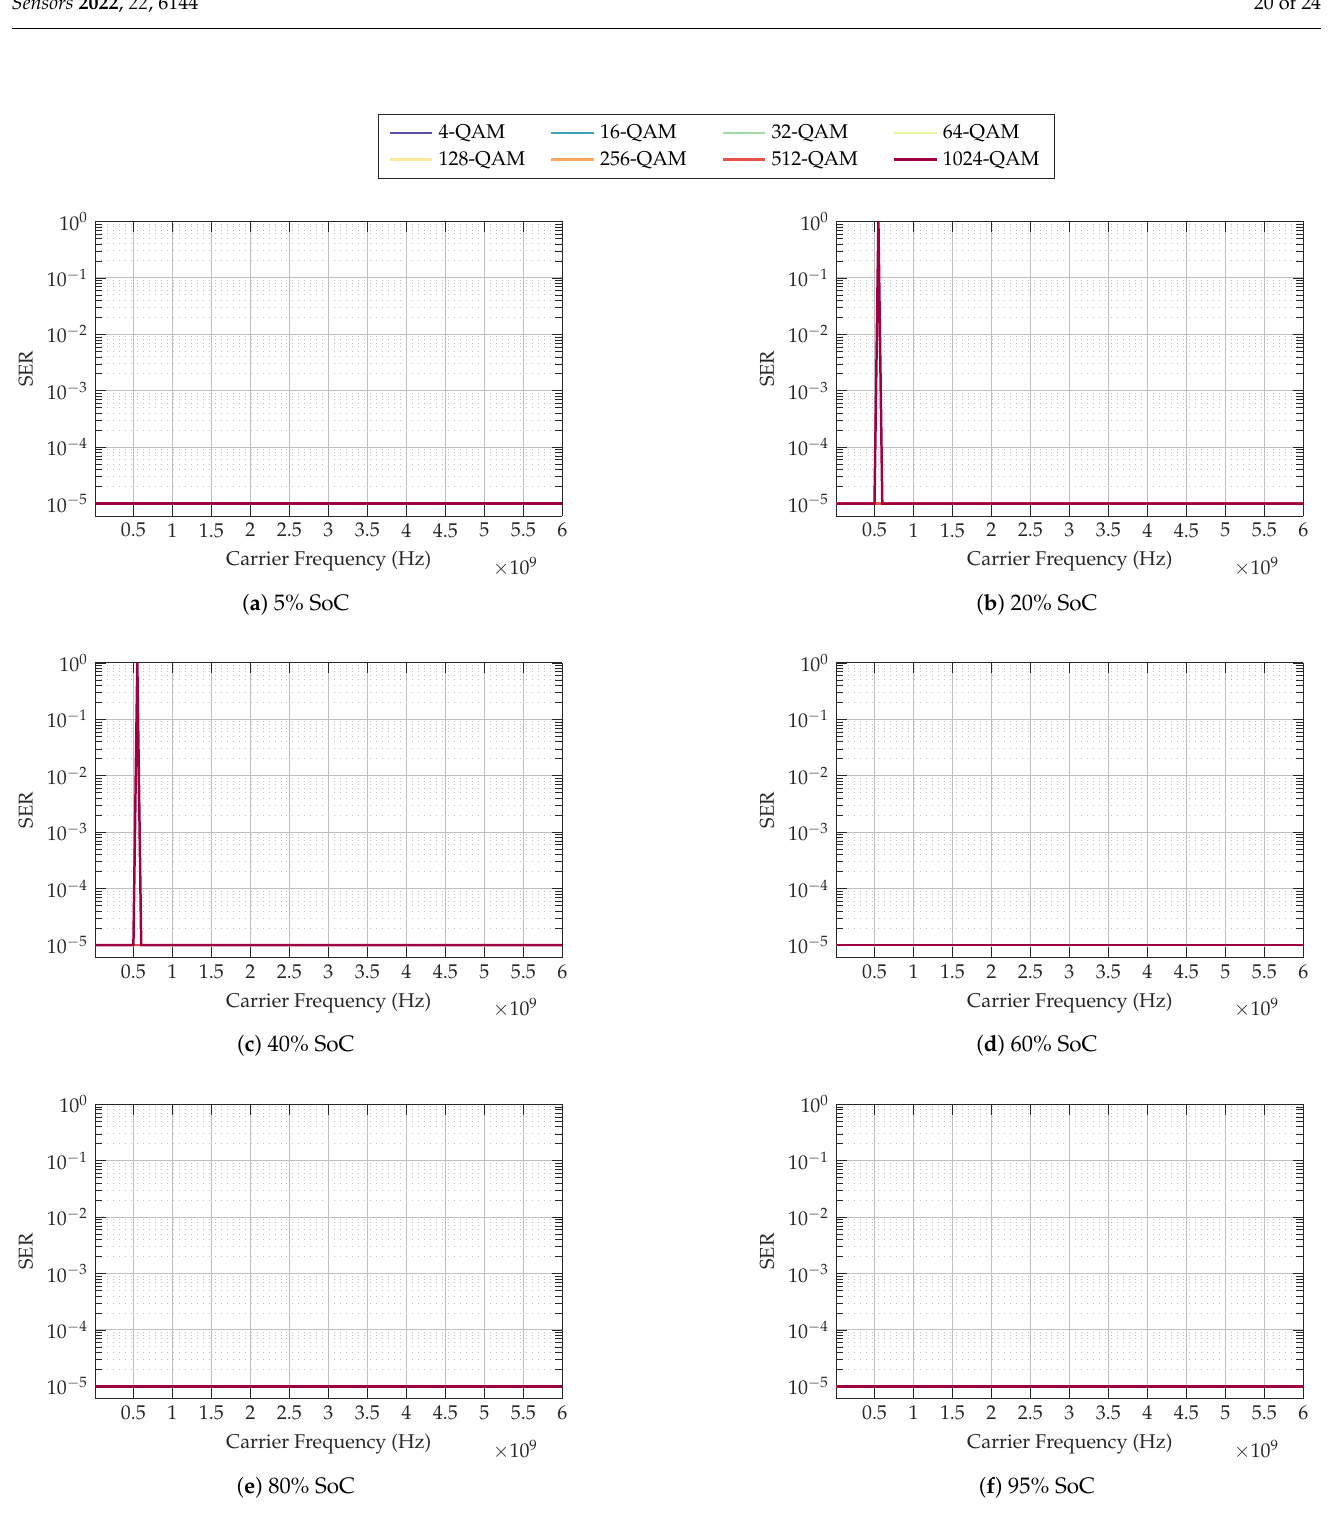
Figure A2. SER for QAM-signals transmitted with a peak output power of cell at various SoC. Each QAM order is represented in a different